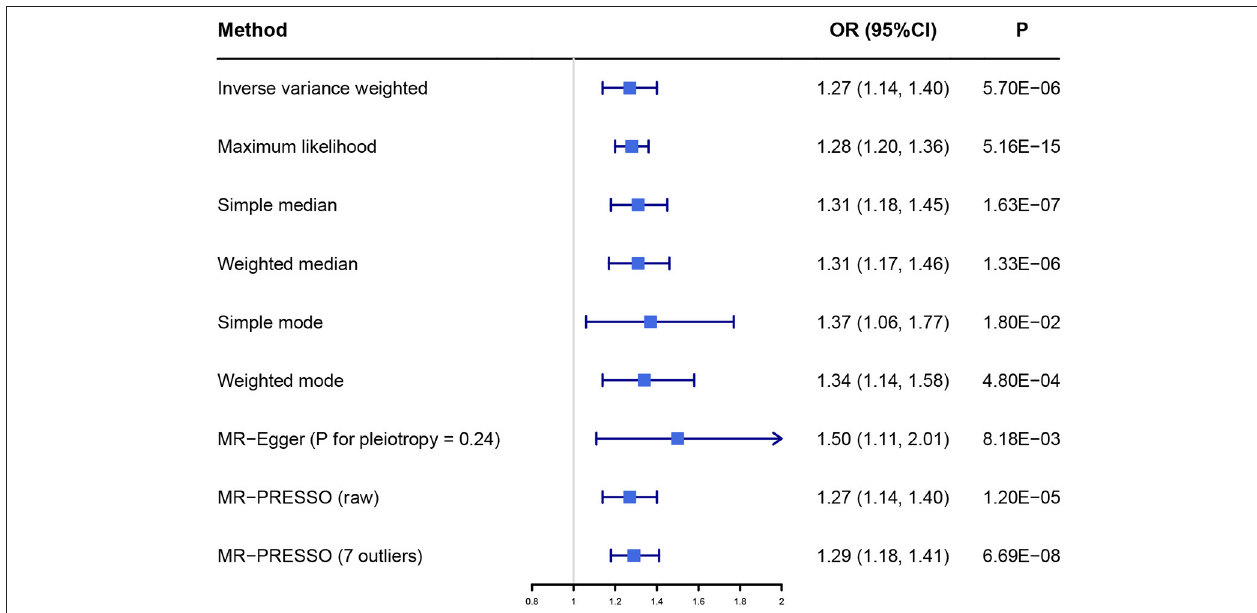
FIGURE 2 | The association between birth weight and atrial fibrillation investigated with different statistical methods. OR, odds ratio; CI, confidence interval; MR, Mendelian randomization; MR-PRESSO, Mendelian Randomization Pleiotropy Residual Sum and Outlier.